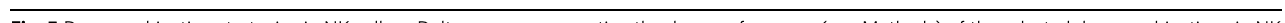
Fig. 5 Drug combination strategies in NK cells. a Delta scores representing the degree of synergy (see Methods) of the selected drug combinations in NK cell lines. Bar heights indicate mean, and error bars the range of two independent experiments. Drug combinations are ranked according to mean delta score. b Dose – response matrices of percent inhibition achieved at indicated doses of ruxolitinib combined with venetoclax or alisertib in cell lines SNK-6 and KHYG-1. Shown are representative results from one out of two experiments. c Dose – response matrices of delta synergy scores achieved at indicated doses of ruxolitinib combined with venetoclax or alisertib in cell lines SNK-6 and KHYG-1. Shown are representative results from one out of two experiments. d Dose – response curves of percent inhibition achieved at indicated doses of ruxolitinib combined with venetoclax or alisertib in cell lines SNK- 6 and KHYG-1. Dots indicate mean and error bars the range of two independent experiments. e Viability percentages for ruxolitinib, venetoclax and alisertib as single agents and in combination across NK cell lines normalized to DMSO and BzCl controls. f Dose – response curves and viability percentages for ruxolitinib, venetoclax, alisertib and combinations in primary NK cells isolated from a patient with a BM NK-cell lymphoproliferation harboring a